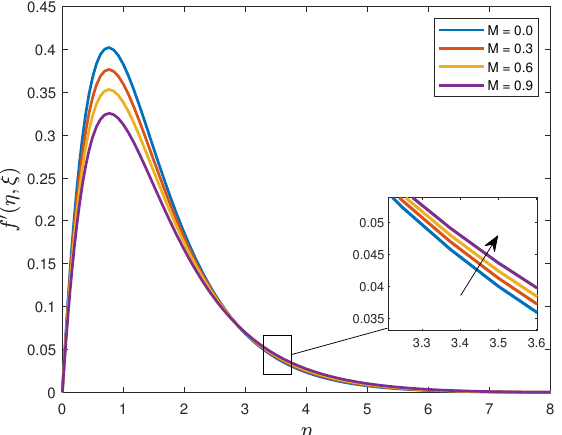
Figure 28. The influence of M on fluid velocity.